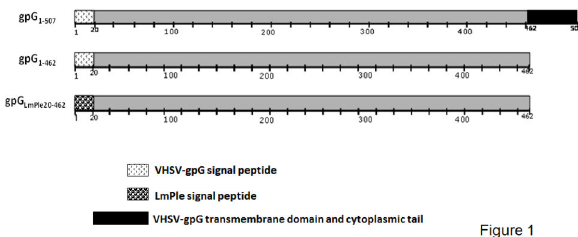
Figure 1. Translation of proteins corresponding to the plasmid constructs used for the experiments. VHSV-gpG constructs are shown with the amino terminus at the left. Amino acids residues from 1 to 20, VHSV-gpG signal peptide; from 20 to 462, VHSV- gpG ectodomain and from 462 to 507 VHSV-gpG transmembrane domain and cytoplasmatic tail. gpG VHSV-gpG. gpG comprises the VHSV-gpG ectodomain including the signal peptide sequence. gpG 1-462 pG ectodomain and the Limanda limanda Pleurocidin (LmPle) signal peptide sequence. doi: